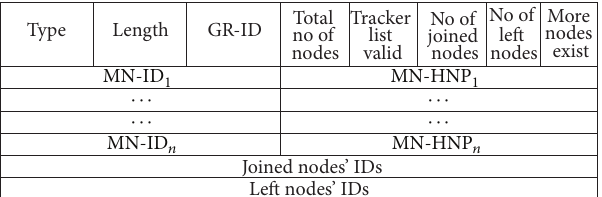
Figure 6: Mobile Network Location Update (MNLU) message.